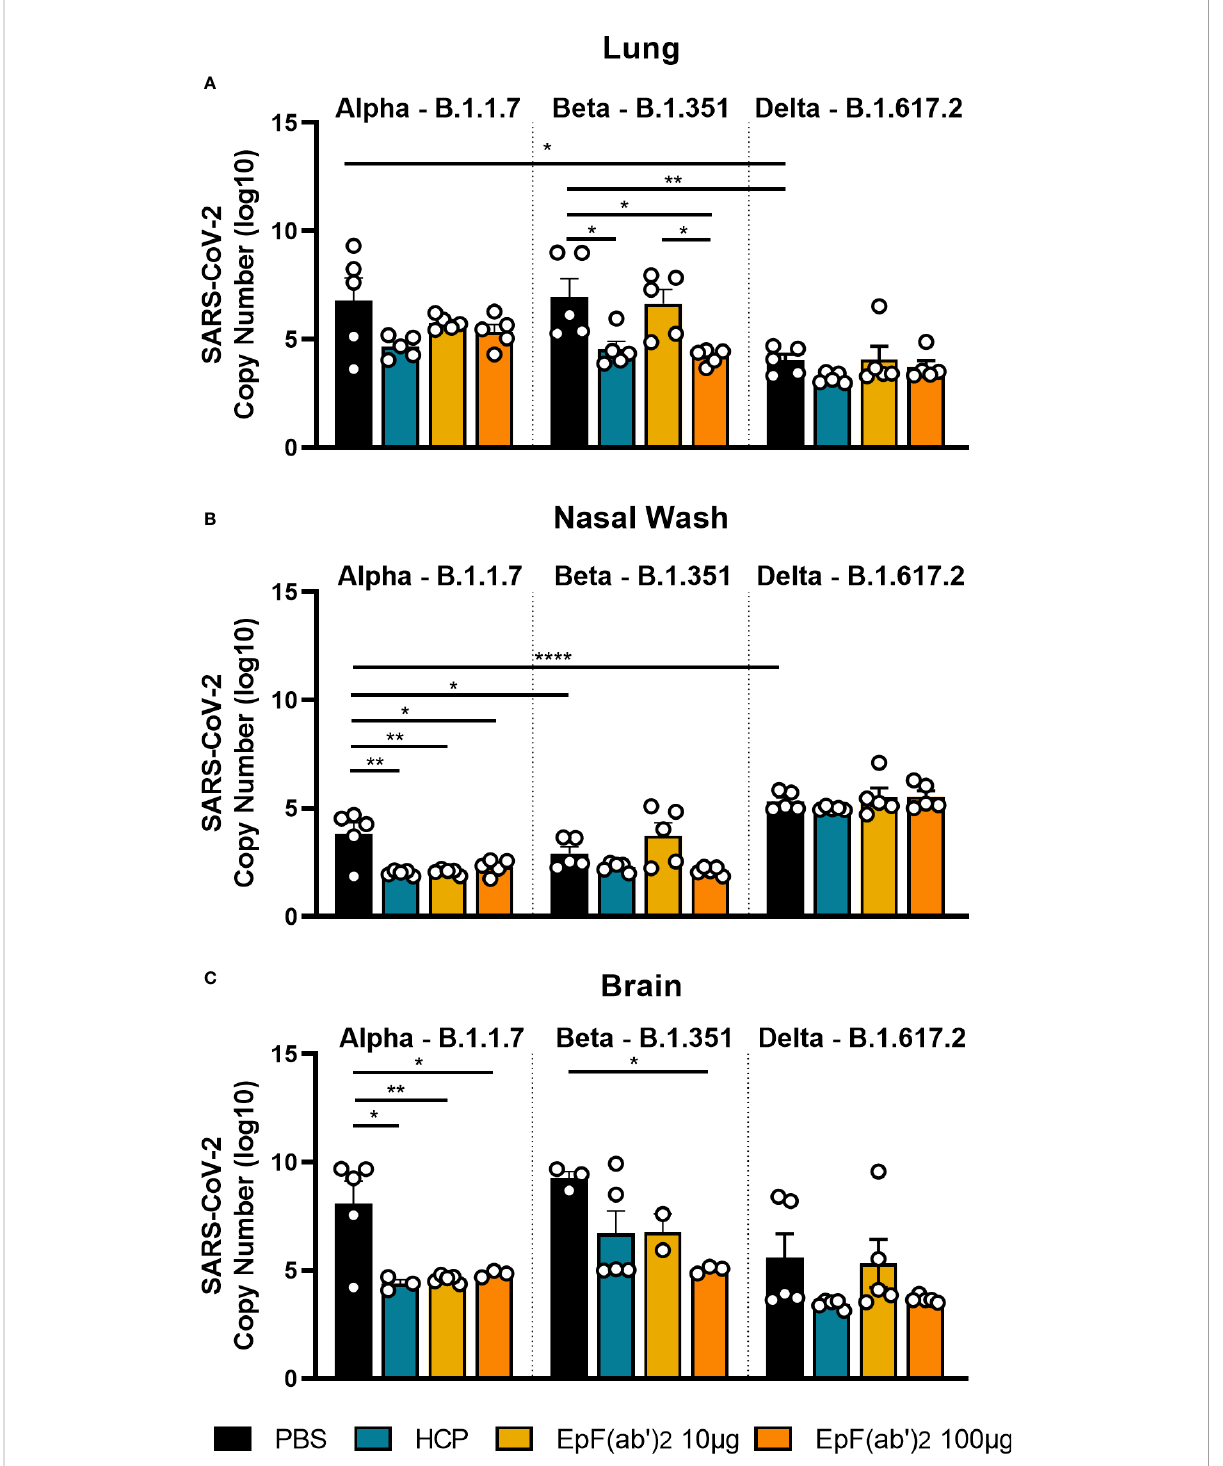
FIGURE 5 Viral burden in lung, nasal wash and brain detected by qPCR. qPCR detection of SARS-CoV-2 viral burden in the lung (A) , nasal wash (B) , and brain (C) at time of euthanasia in mice infected with Alpha, Beta, or Delta. Kruskal-Wallis with Dunn ’ s multiple comparisons test was used to compare viral burden in the tissue (*p<0.05;**p<0.01;